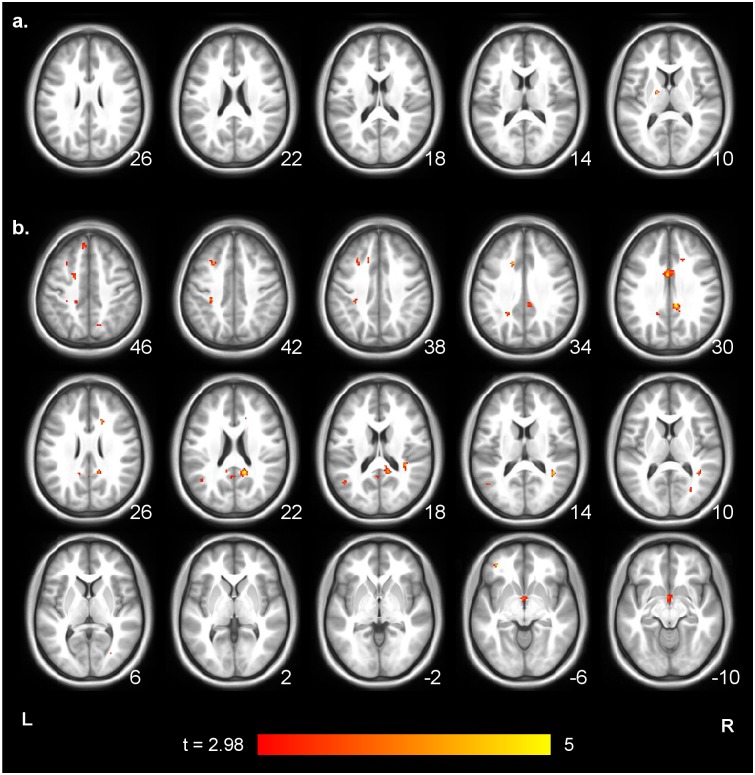
Axial slices showing the activated voxels for the contrasts.a) (Action Movies—Control Movies) fair—(Action Movies—Control Movies)unfair, not masked with execution and b) (Action Movies—Control Movies)unfair—(Action Movies—Control Movies) fair not masked with execution. Both thresholded at p < .005 uncorrected (t>2.98), min cluster size 10 voxels.